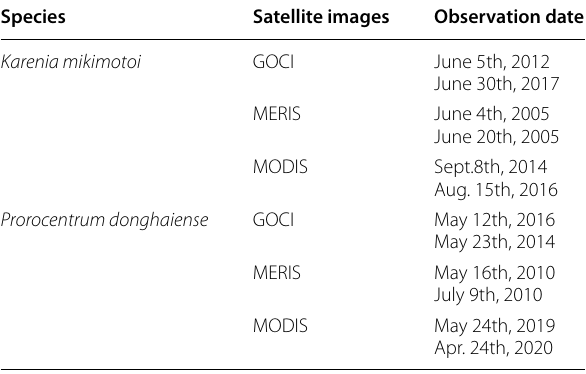
Table 1 Satellites images concurrent with the bloom occurrence time of GOCI, MODIS and MERIS Satellite